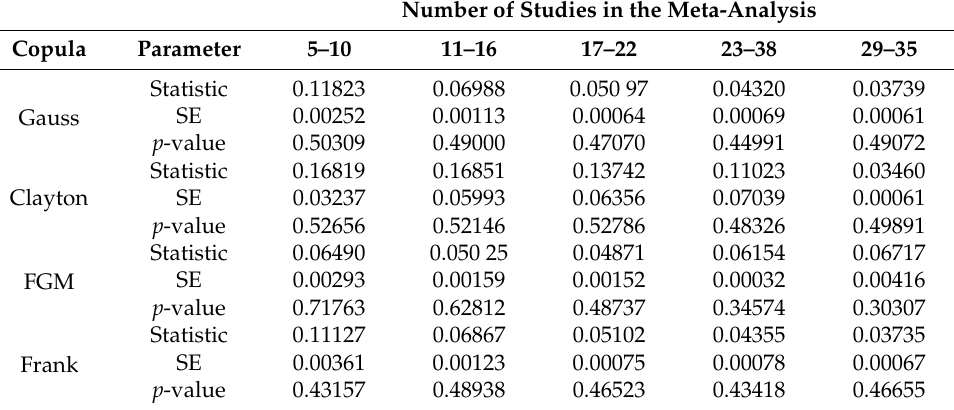
Table 4. Results of goodness-of-fit tests for the copula model based on statistic, SE and p -value on the (0,1) scale. The results presented here come from the situation in which the number of studies (between 5 and 35 studies) in each meta-analysis was randomly generated. The total number of persons included in each study was randomly sampled using a uniform distribution U (30; 1 255). Number of Studies in the